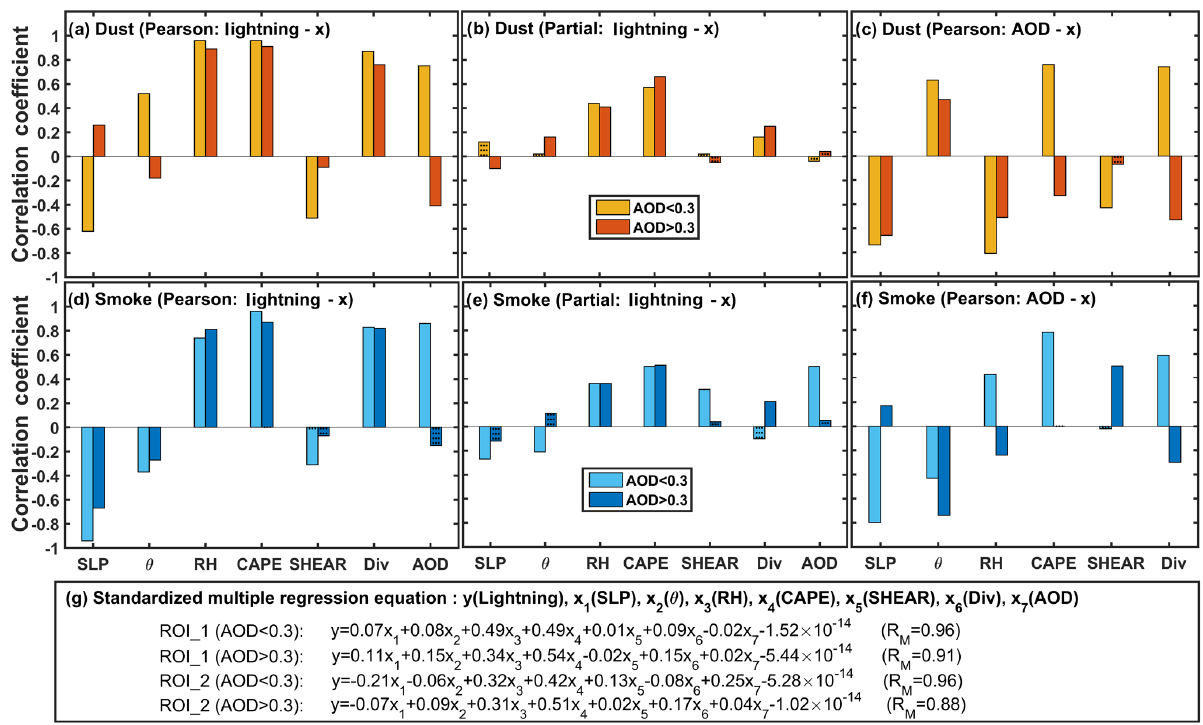
Figure 12. (a, d) Pearson correlation coefficients of the linear regression relationships between the lightning flash rate and the six dynamic– thermodynamic variables and aerosol optical depth (AOD). (b, e) Partial correlation coefficients of the relationships between the lightning flash rate and any influential factor (AOD or dynamic–thermodynamic variables) with the others as control variables. (c, f) Pearson correlation coefficients of the linear regression relationships between AOD and any given dynamic–thermodynamic variable. The top panels are for the dust-dominant region, and the bottom panels are for the smoke-dominant region. Those bars with dots on them signify success of the statistical significance test at the 95% confidence level. Also shown are standardized multiple regression equations of the lightning flash rate ( y ) onto the six dynamic–thermodynamic variables ( x 1 − x 6 ) and AOD ( x 7 ) and standardized multiple correlation coefficients ( R M ). The six dynamic–thermodynamic variables are sea level pressure (SLP, x 1 ), potential temperature ( θ , x 2 ), mid-level relative humidity (RH, x 3 ), mean convective available potential energy (CAPE, x 4 ), vertical wind shear (SHEAR, x 5 ), and 200hPa divergence (Div, x 6